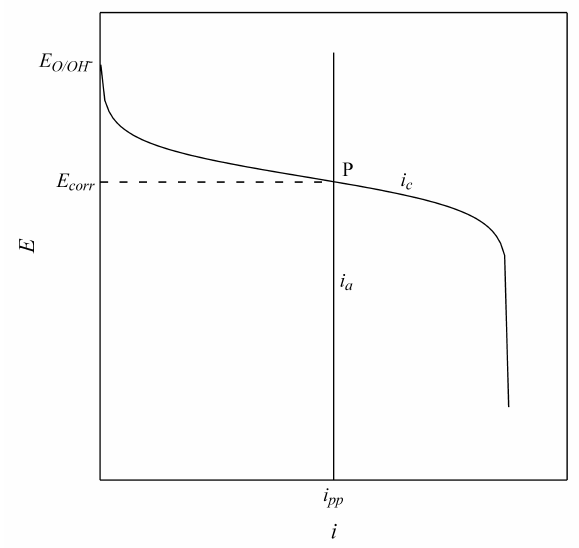
Figure 11. Corrosion potential of a stainless steel in a neutral aerated solution, defined by the point of intersection P of curves i a and i c